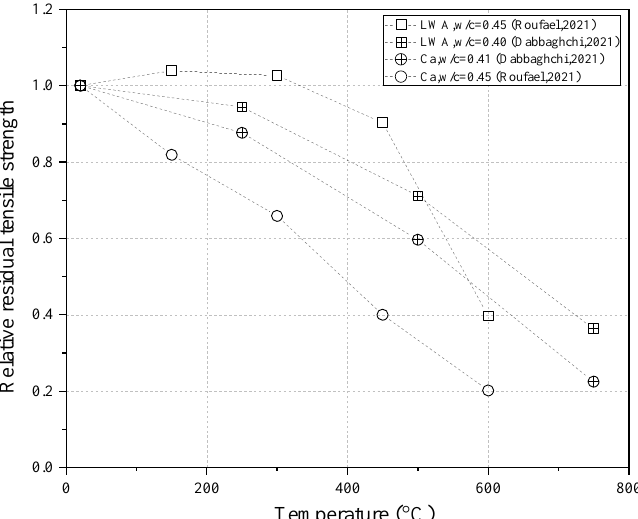
Figure 15. The relative residual tensile strength of concrete containing lightweight aggregate (LWA) and calcareous (Ca) aggregate [79,83].